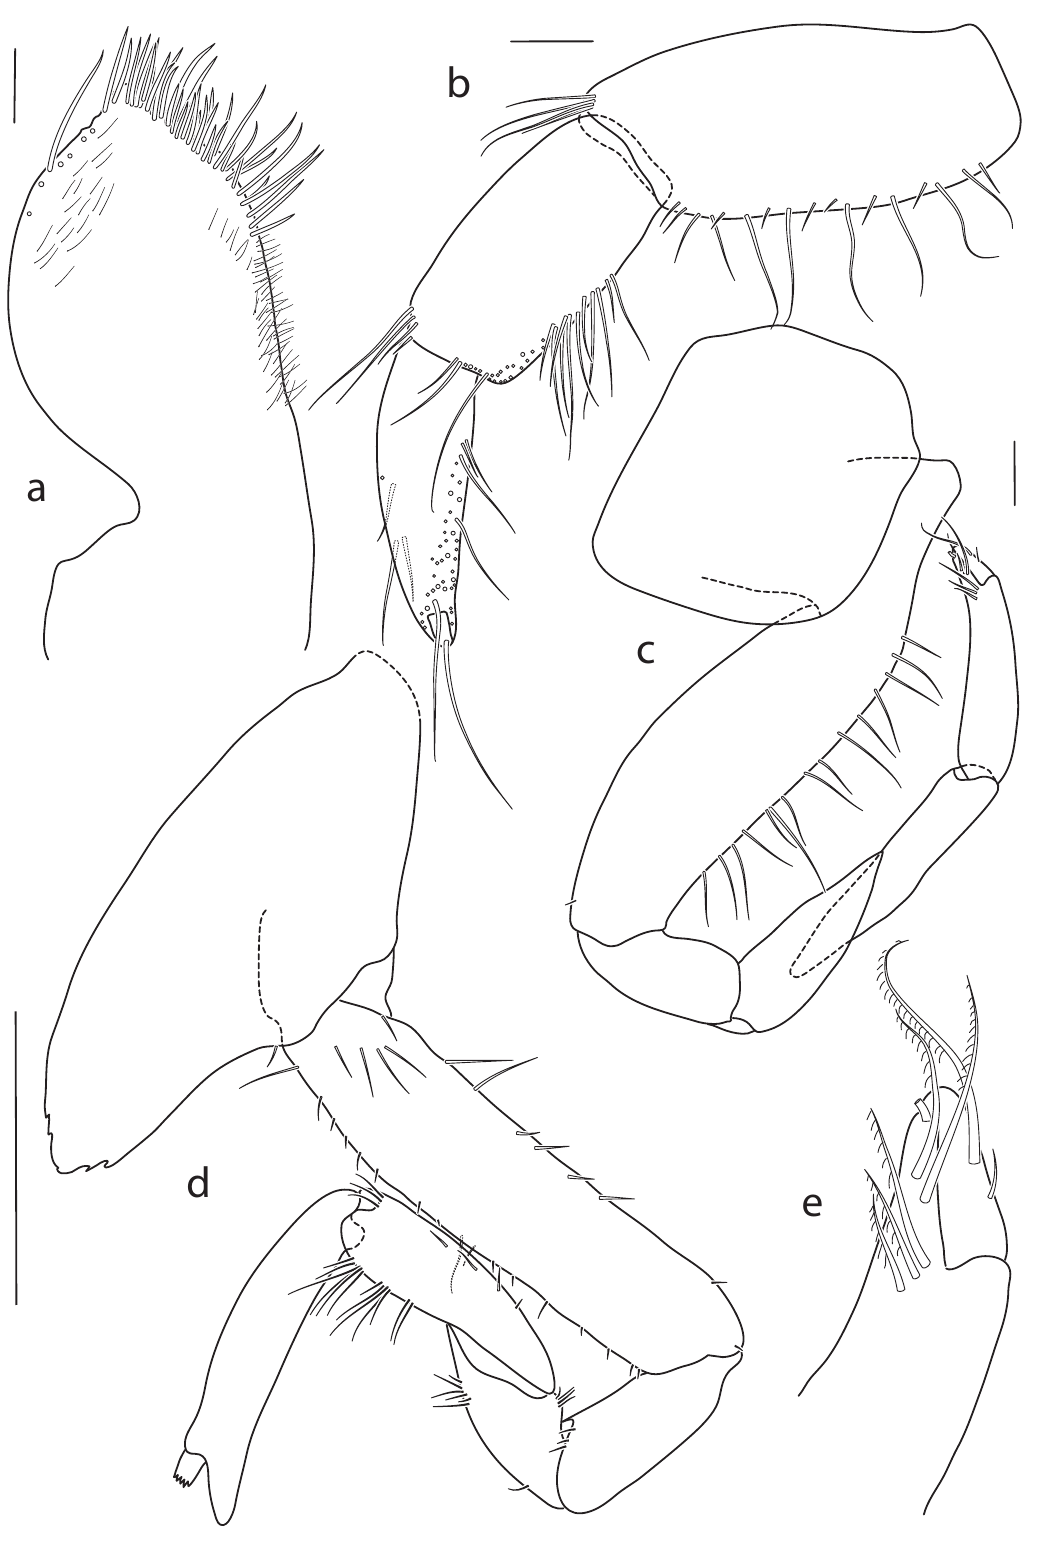
Fig. 20. Labriphimedia vespuccii K.H. Barnard, 1931, ♀, 21 mm (ZMB 34096). a . Outer plate of maxilliped. b . Palp of maxilliped. c . Gnathopod 1. d . Gnathopod 2, setae on propodus omitted. e . Chela of gnathopod 1. Scale bars: a–b, e = 100 µm; c = 200 µm; d = 1